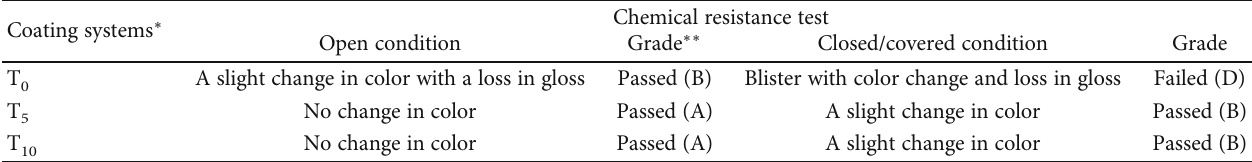
Table 3: Results of chemical resistance testing of the virgin epoxy coating and titanium-embedded epoxy coatings in open and covered conditions as per ASTM